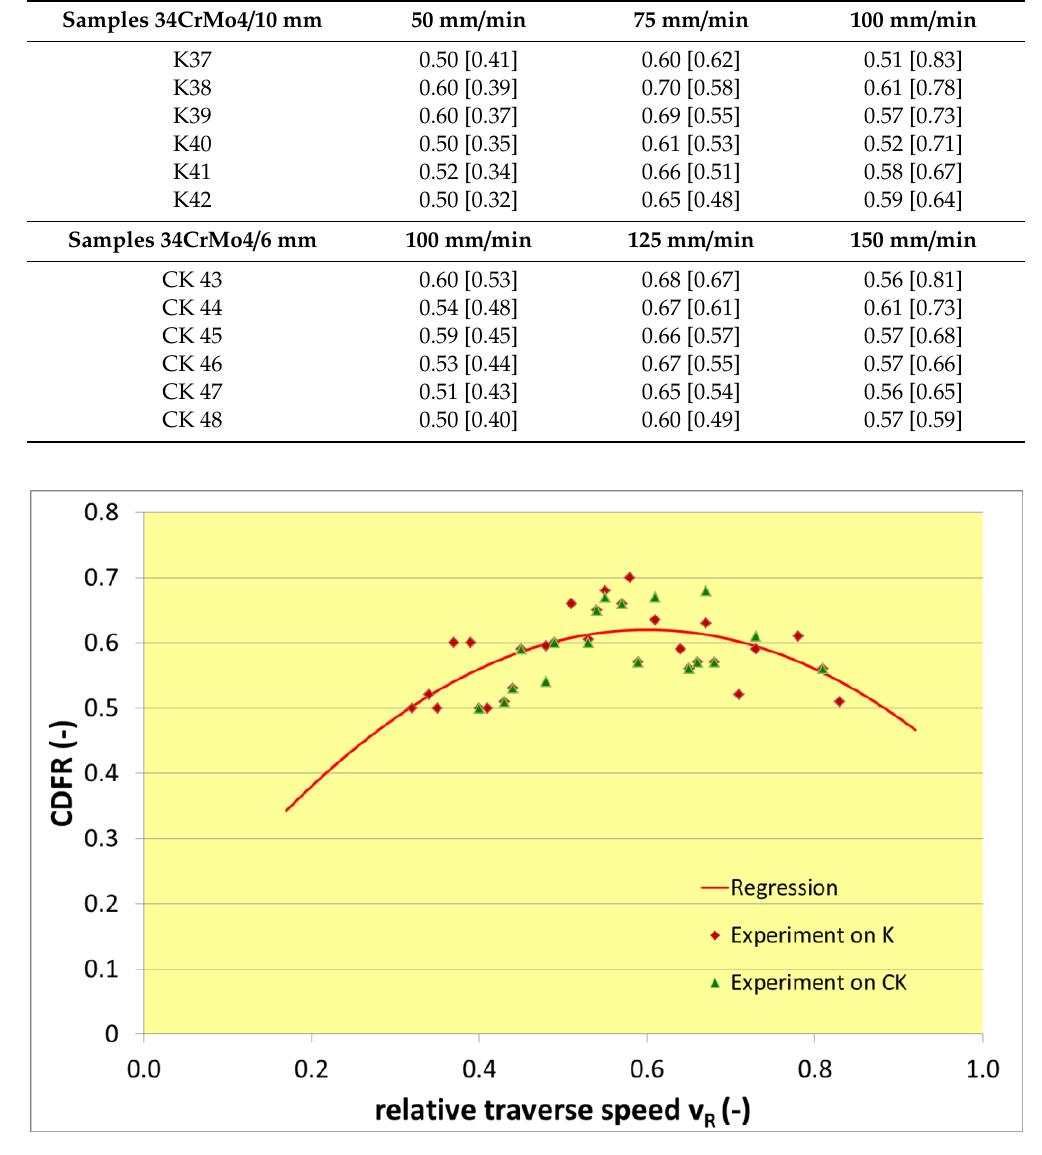
Figure 8. Graph of relationship between relative traverse speed and CDFR.